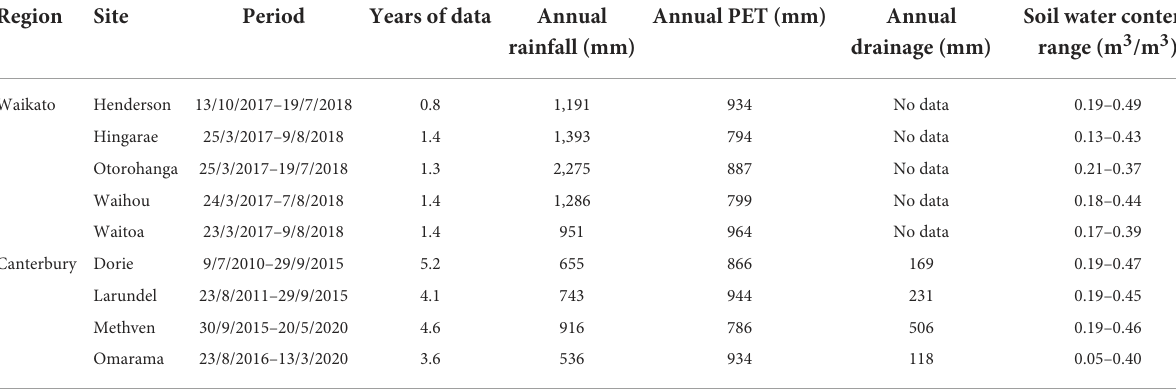
TABLE 2 Summary of climate and soil water content data at case study sites.